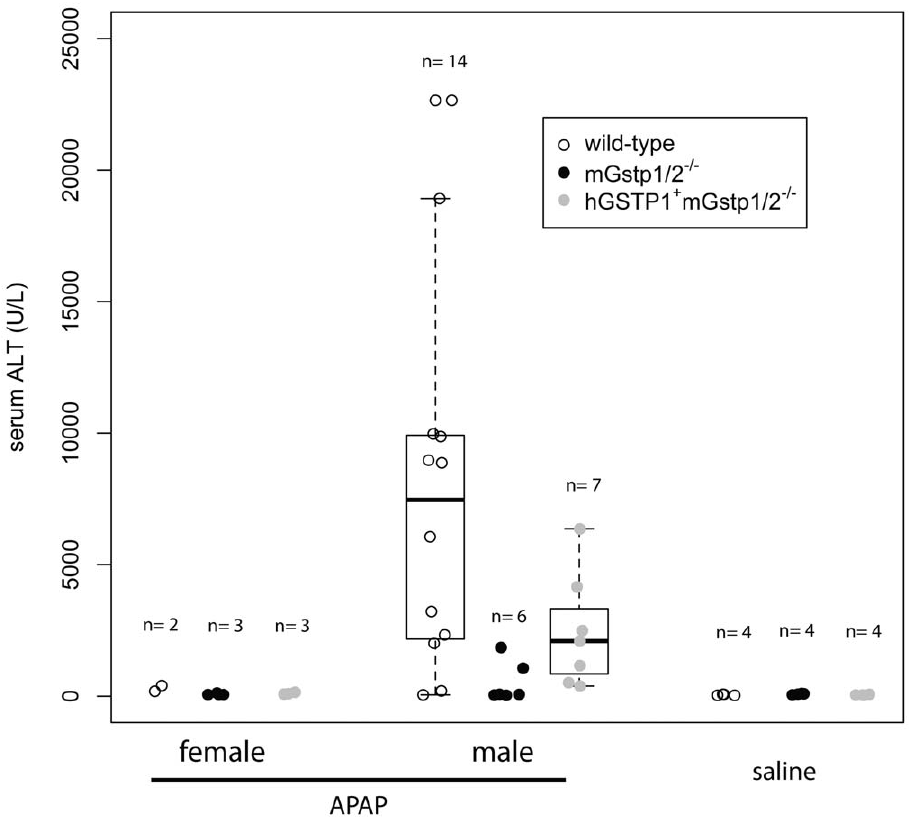
Figure 4. APAP-induced liver injury in male and female wild type, mGstp1/2 2 / 2 , and hGSTP1 + mGstp1/2 2 / 2 mice. Serum ALT levels 24 hours after intraperitoneal injection of 300 mg/kg APAP or saline are shown. Compared to mGstp1/2 2 / 2 mice, mGstp1/2 + / + (p , 0.04) and hGSTP1 + mGstp1/2 2 / 2 (p , 0.03) mice exhibited significantly higher ALT elevations in response to APAP overdose. Data was analyzed by Wilcoxon Rank Sum